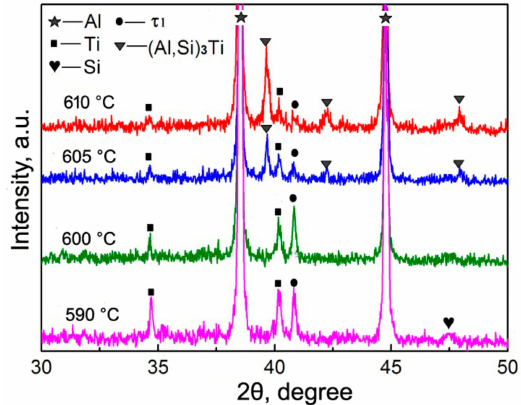
Figure 4. XRD patterns of the composites thixoformed at different reheating